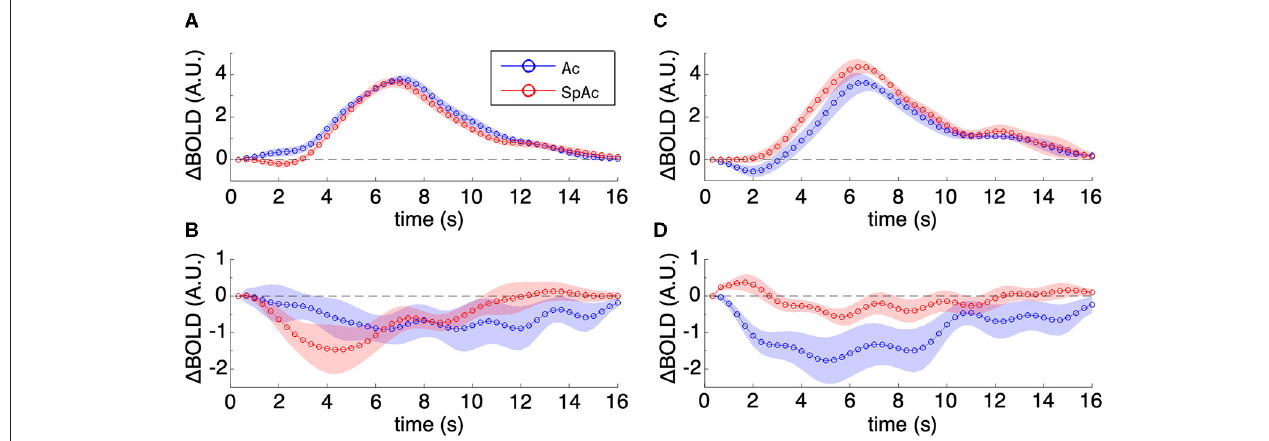
FIGURE 6 | Group mean HRFs in PVC and mPFC. (A) Majority group mean HRFs of PVC. SpAc emphasis enhanced initial dip amplitude ( P < 0.01) while the remainder of the HRF did not change significantly. (B) Majority group mean HRFs of mPFC. The HRFs in pre-frontal cortex showed a sustained suppression ( P < 0.01), which was initially enhanced and then later reduced by SpAc emphasis. (C) Minority group mean HRFs of PVC. SpAc emphasis significantly reduced initial dip amplitude and increased the positive overshoot response in the ( P < 0.05). (D) Minority group mean HRFs of mPFC. SpAc emphasis introduced an initial positive dip ( P < 0.05) followed by milder sustained suppression ( P < 0.01). Error bars are SEM across